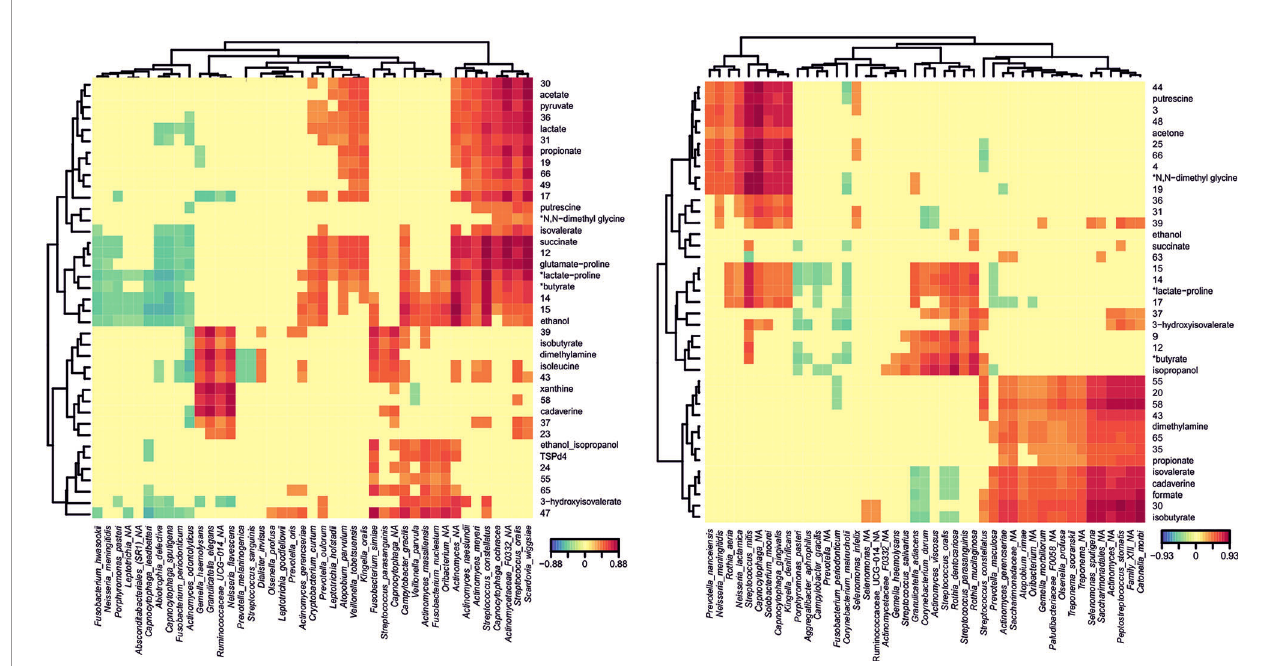
FIGURE 5 | Metabolomic pro fi les of dental plaque samples from Caries-experienced (CAR) and Caries-Free (CF) individuals. NMR was used to quantify metabolites produced by dental plaque samples exposed to high sugar levels. The heatmaps show those metabolites with a signi fi cant correlation with bacterial species identi fi ed by Illumina sequencing of the 16S rRNA in CAR (left panel) and CF (right panel) individuals. The degree and sign of the correlations are represented by the color code shown below. Each bacterial species shows a metabolomic pro fi le (columns), and those pro fi les were clustered according to their similarity (top and left dendrograms). Those metabolites for which the NMR peaks were not unique are marked with an asterisk next to the putative metabolite